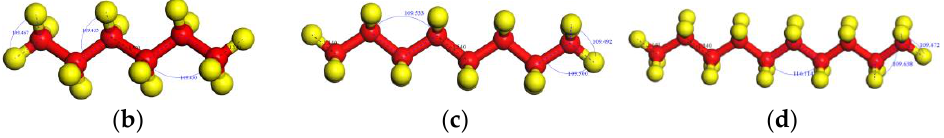
Figure 2. Typical crude oil molecules models: ( a ) C 6 H 12 , ( b ) C 6 H 14 , ( c ) C 8 H 18 , ( d ) C 10 H 22. Colored balls represent C in red, H in yellow.